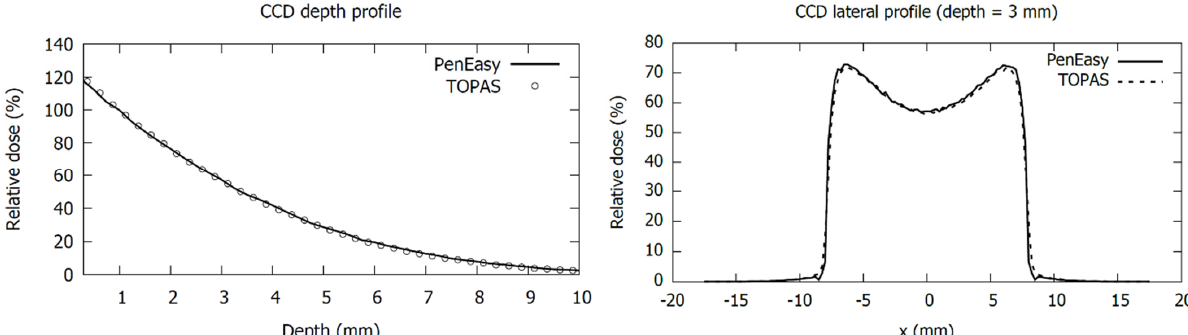
Figure 4. Comparison of central ‐ axis depth profiles ( left panel ) and 3 mm depth lateral profiles ( right panel ) for a CCD plaque simulated with TOPAS and PenEasy. Dose values are normalized to 1 mm depth.